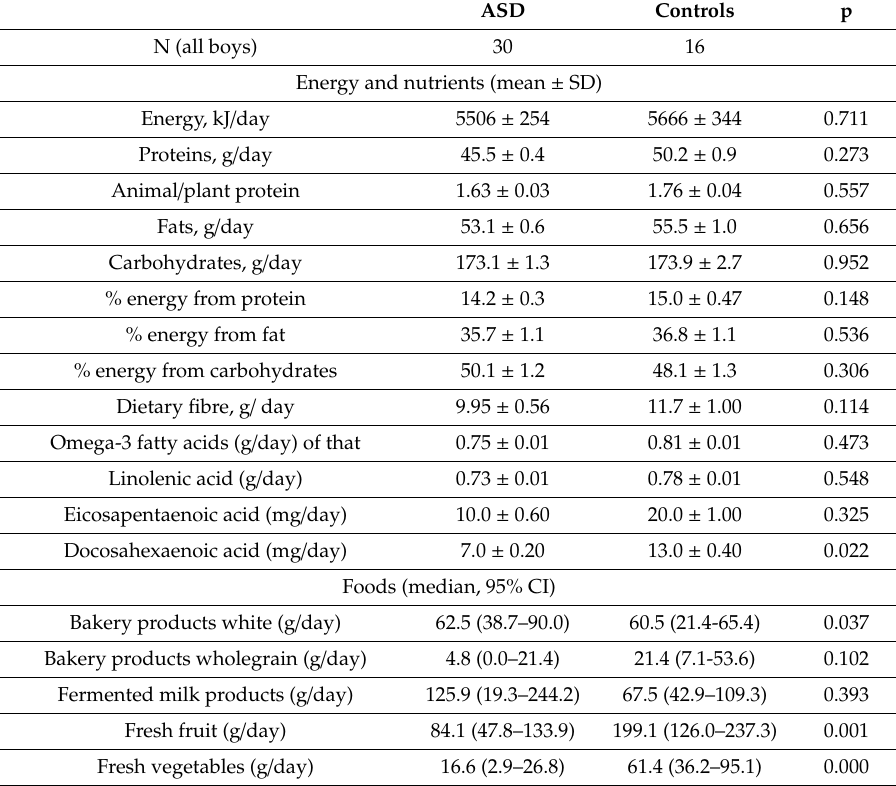
Table 2. Daily intakes of energy, selected nutrients and foods in cohorts of individuals with ASD and neurotypical controls.